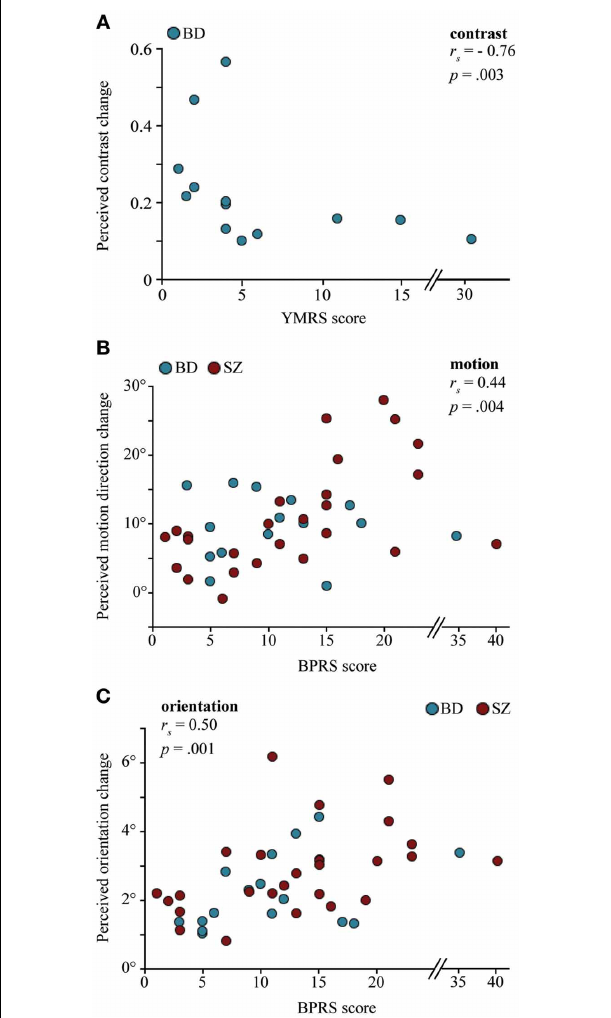
FIGURE 4 | The relationship between the magnitude of contextual effects and clinical measures in individuals with bipolar disorder (BD) and individuals with schizophrenia (SZ). (A) Correlation between the Young Mania Rating Scale (YMRS) symptoms ratings and perceived contrast changes in the surround contrast illusion in BD: Higher mania scores were associated with weaker contrast illusion. (B and C) Correlations between Brief Psychiatric Rating Scale (BPRS) symptoms ratings and perceived motion direction changes in the motion repulsion task and perceived orientation changes in the orientation repulsion task. Patients with higher BPRS scores were more likely to exhibit stronger repulsion effects. Correlations remained significant when excluding three potential YMRS outliers in (A), r s = − 0 . 68, p = 0 . 03, and 2 potential BPRS outliers in (B) and (C) , r s = 0 . 53, p = 0 . 001; r s = 0 . 47, p = 0 . 002,